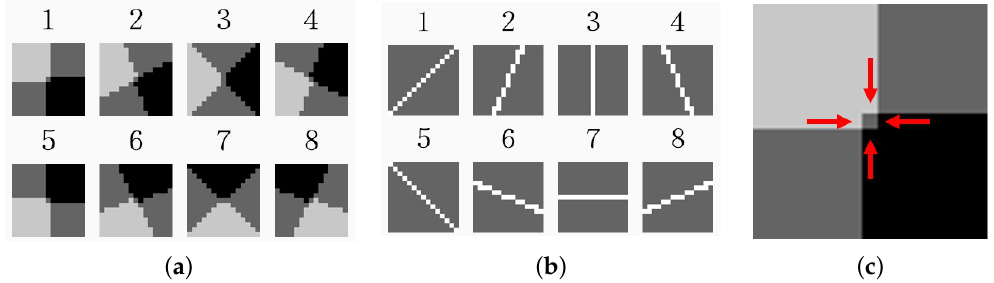
Figure 2. Direction detection templates and smoothing templates: ( a ) Direction detection templates, ( b ) smoothing templates, ( c ) the first direction